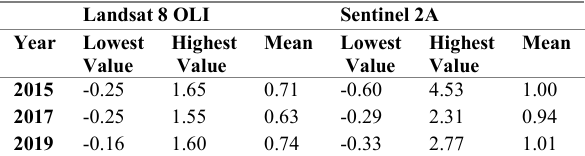
Table 6: GSI Value Ranges for Landsat 8 and Sentinel 2A 3.5 Comparative Analysis of Landsat 8 OLI and Sentinel